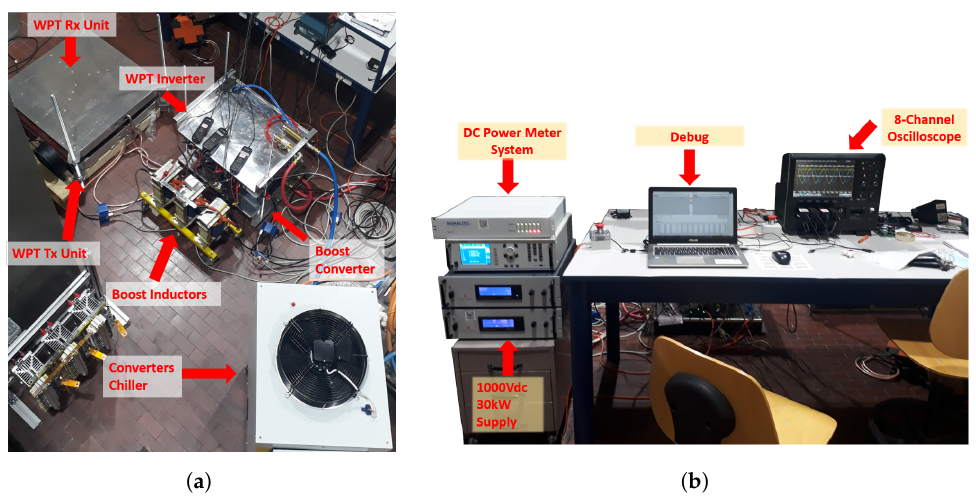
Figure 10. ( a ) Power test-bench with WPT structure, WPT inverter and boost converter and chiller. ( b ) Control bench, supply and measurement